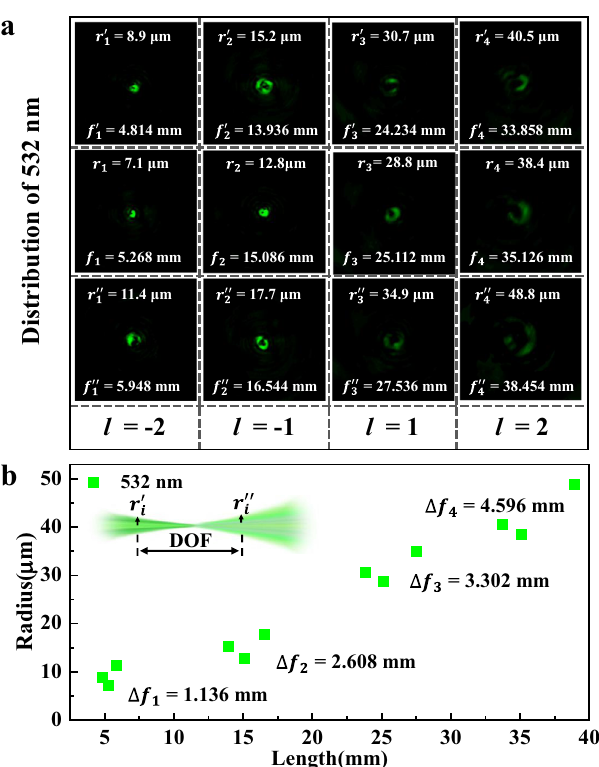
Fig. 5 | Experimental focal spots, radii, and the DOF of the VDM at 633nm. a Collected fi eld distributions, focal length, and radii of 633nm for adjacent four focalplaneswiththeOAMof − 2, − 1,1,and2. b Depictofthestatisticalresultsforthe focal length, radii, and the DOF of the focal point for 633nm.